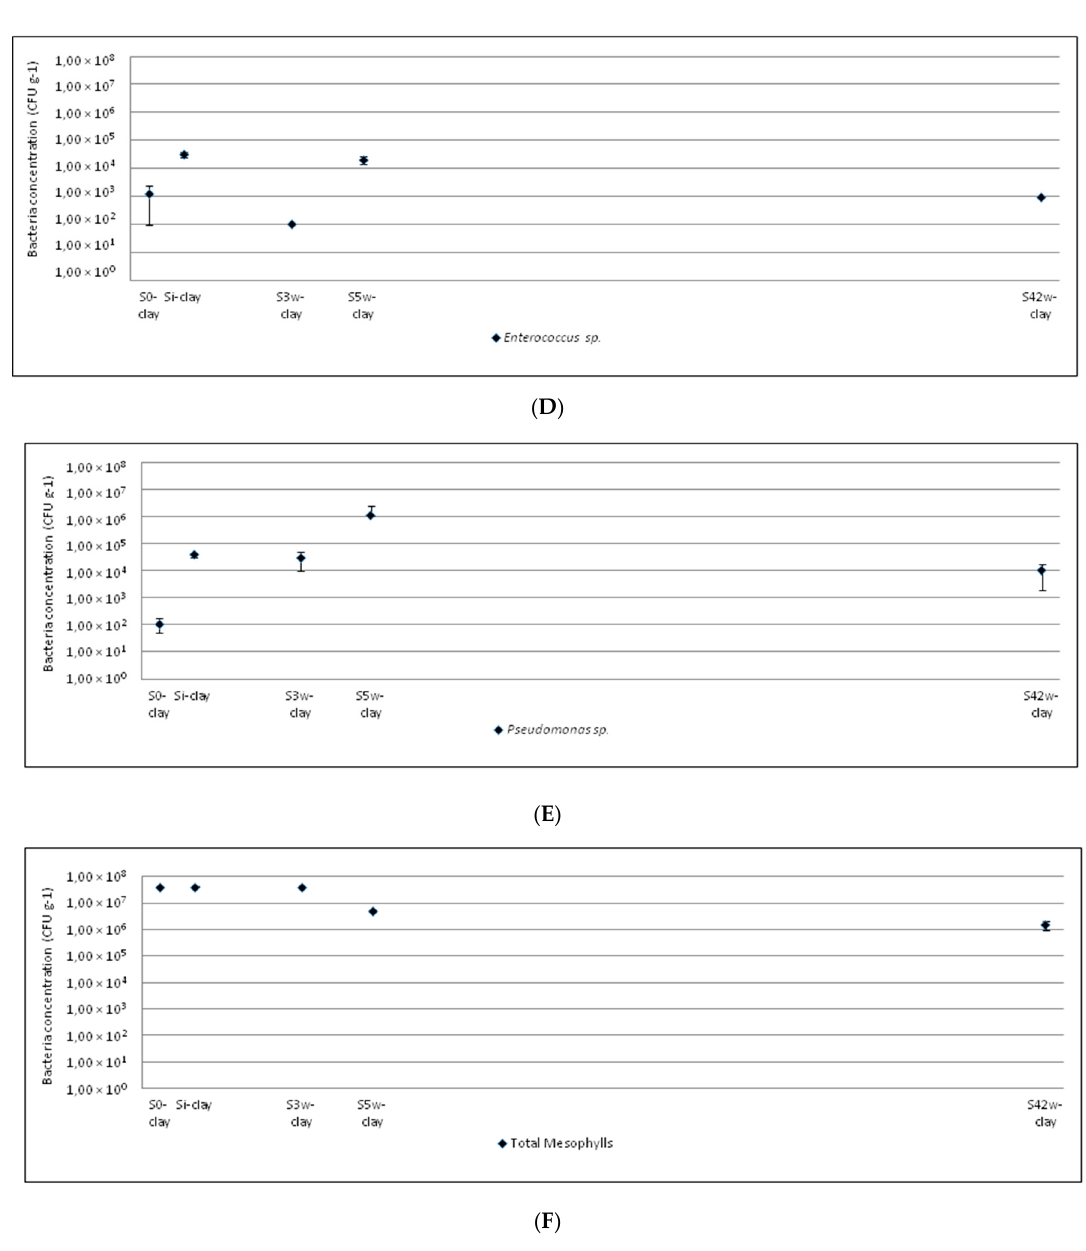
Figure 1. Evolution of microorganism concentrations in clayey soil amended with sewage sludge: ( A ) total coliforms; ( B ) Escherichia coli; ( C ) Staphylococcus aureus ; ( D ) Enterococcus sp.; ( E ) Pseudomonas sp.; ( F ) total mesophylls.